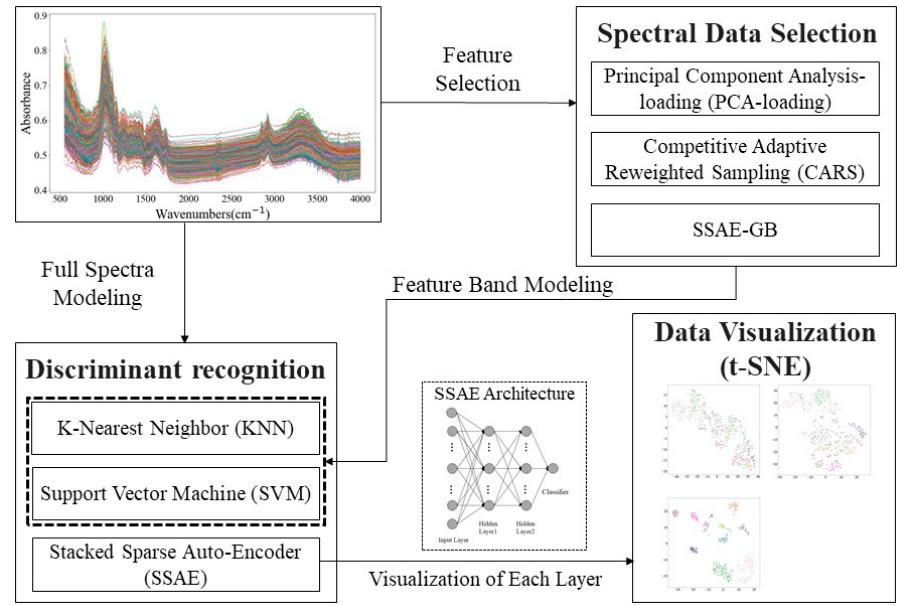
Figure 6. Experimental flow chart.